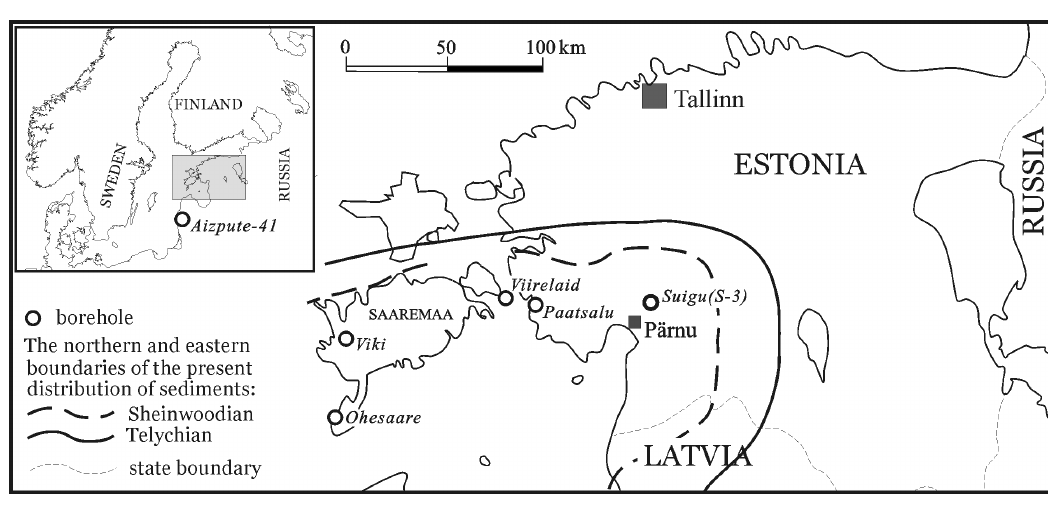
Fig. 1. Location of the sections referred to in the